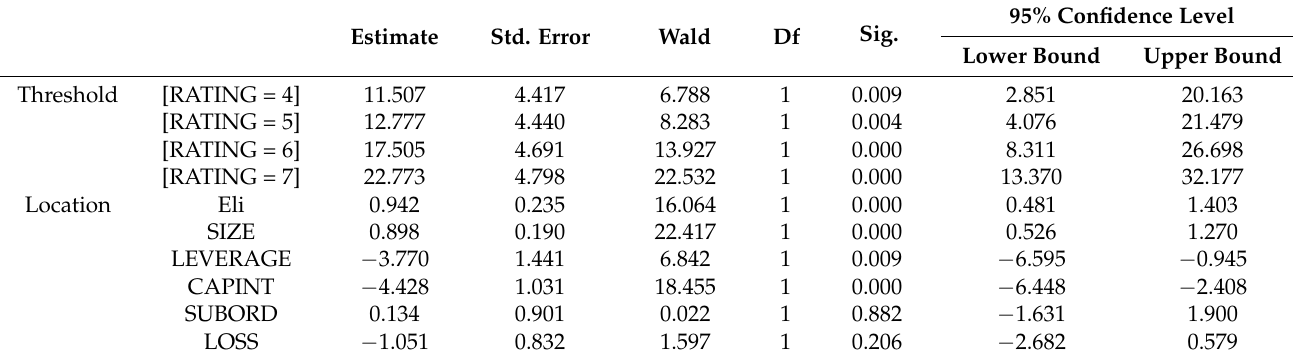
Table 8. Parameter